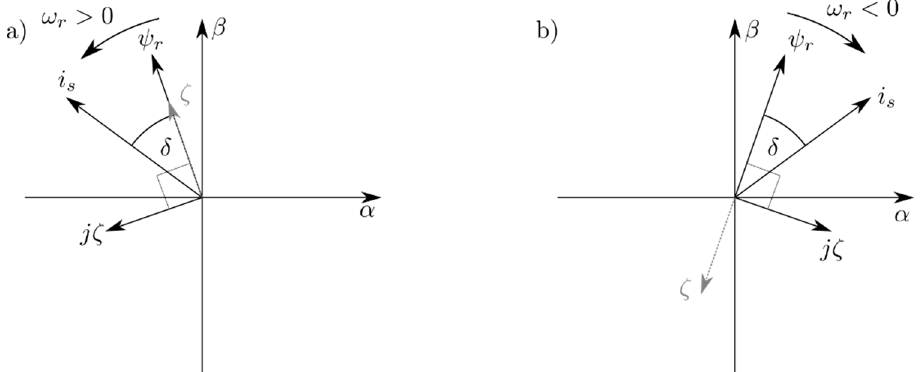
Figure 6. State variables from the right side of the first equation of the extended induction machine model presented as rotating vectors for: ( a ) positive speed values (vectors rotating counterclockwise) and ( b ) negative speed values (vectors rotating clockwise).